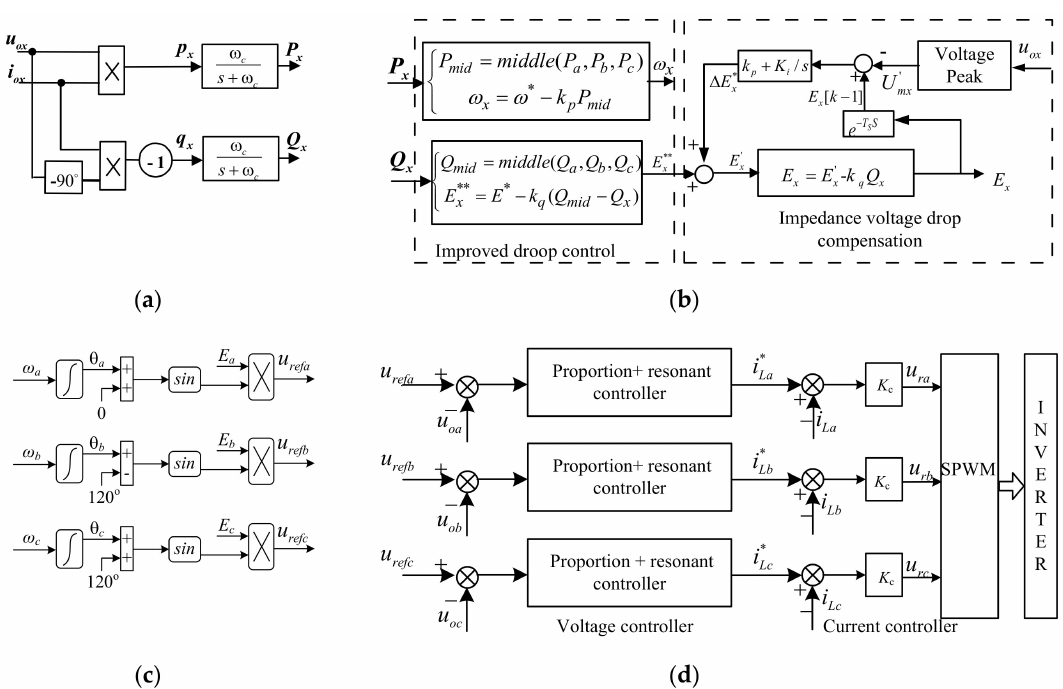
Figure 6. Block diagram of the control scheme. ( a ) Average power calculation; ( b ) Improved droop control and impedance voltage drop compensation; ( c ) Synthesis process of the reference voltage; ( d ) Voltage and current control